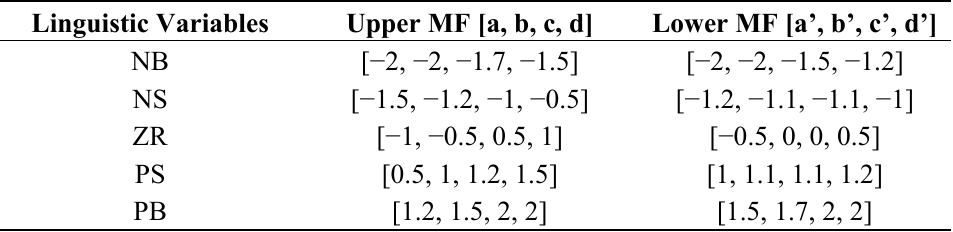
Table A1. Upper and lower membership